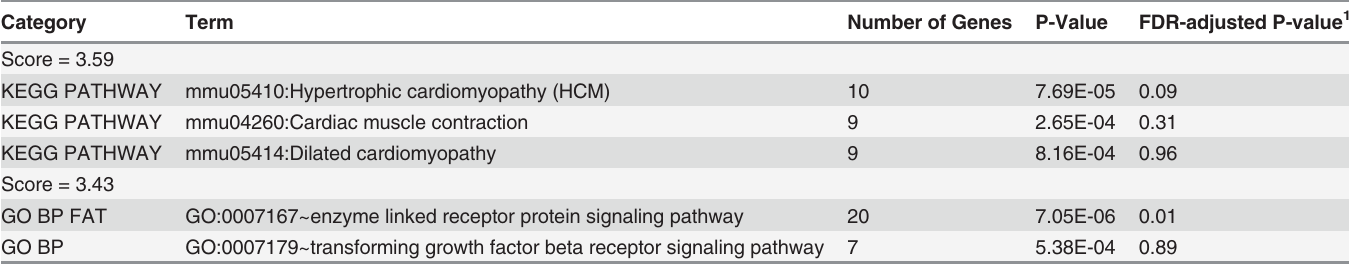
Table 8. Enriched (enrichment score > 3.0) clusters of Gene Ontology (GO) biological process (BP), molecular function (MF) Functional Annotation Tool (FAT) categories, and KEGG pathways among the genes differentially expressed between myostatin-reduced and wild-control mice (FDR-adjusted P-value <